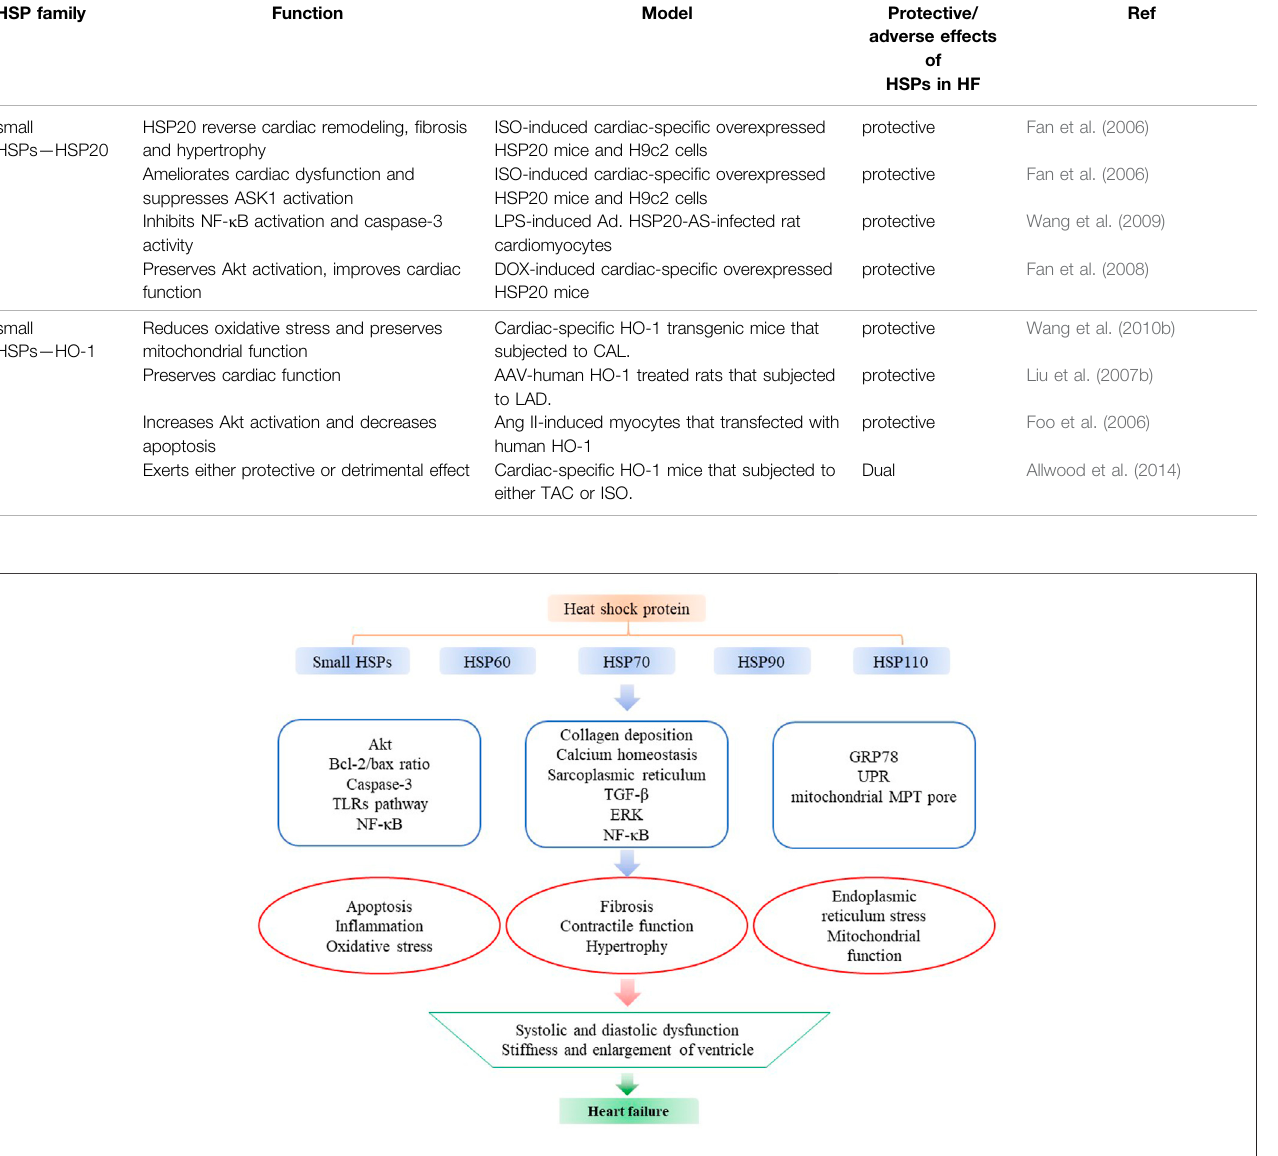
Frontiers in Pharmacology |